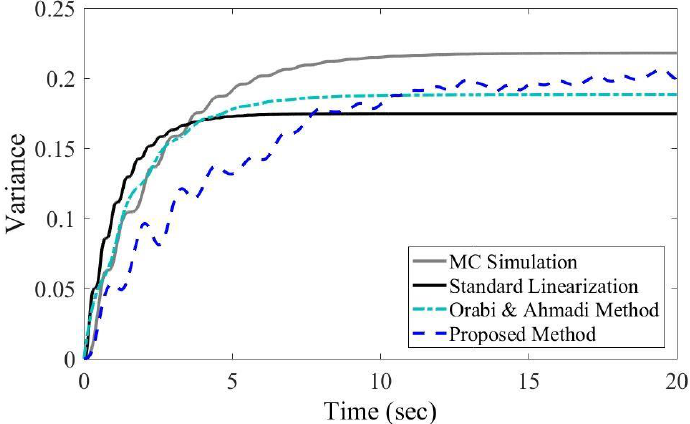
Figure 4. Mean square displacement response due to stationary excitation. ( γ = 10.0, μ = 1.0).